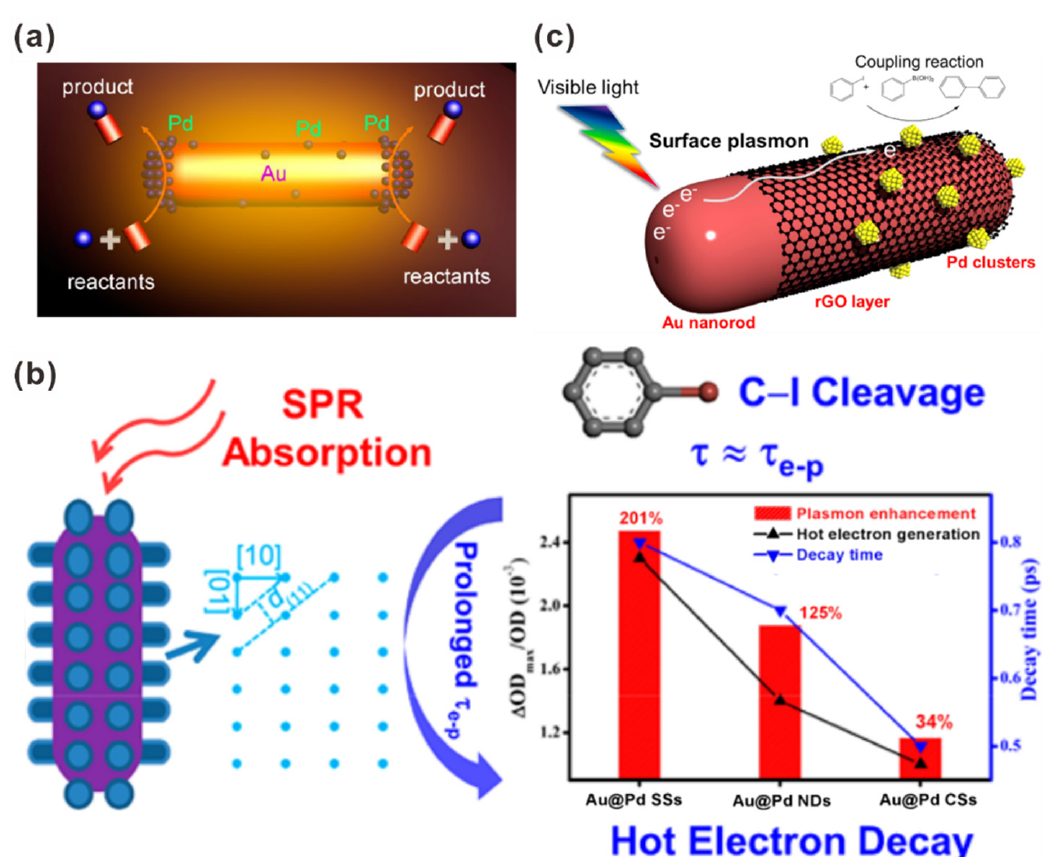
Figure 12. NIR-light-induced plasmonic photocatalysts for C–C cross-coupling. ( a ) Au–Pd nanostructures. Reproduced with permission from Reference [127]. Copyright 2013 American Chemical Society. ( b ) AuNR@Pd superstructures. Reproduced with permission from Reference [129]. Copyright 2017 American Chemical Society. ( c ) Pd-graphene-AuNR nanocomposites. Reproduced with permission from Reference [131]. Copyright 2019 American Chemical Society.